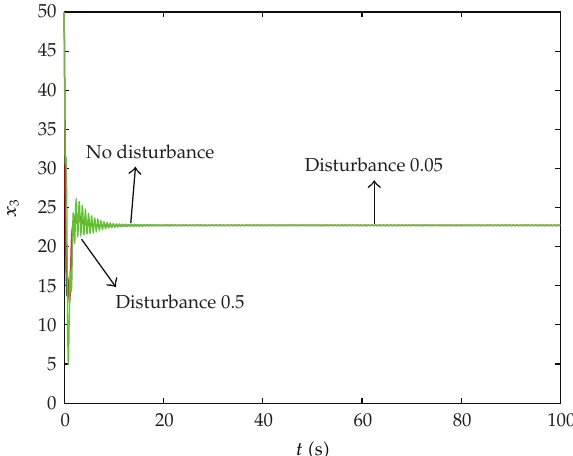
Figure 10: Trajectories of the state variable x 3 by T2ABFC with external disturbances.